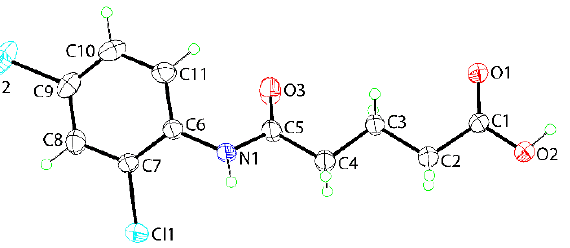
Figure 2. The molecular structure of ( 1 ) showing atom labeling and displacement ellipsoids at the 35% probability level.